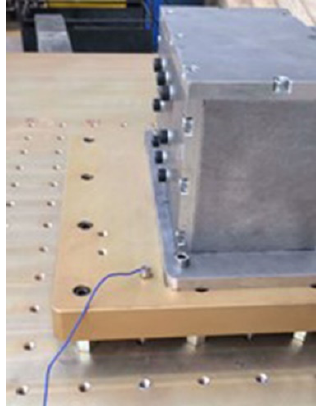
Figure 11. Accelerometer and the dummy instrument.